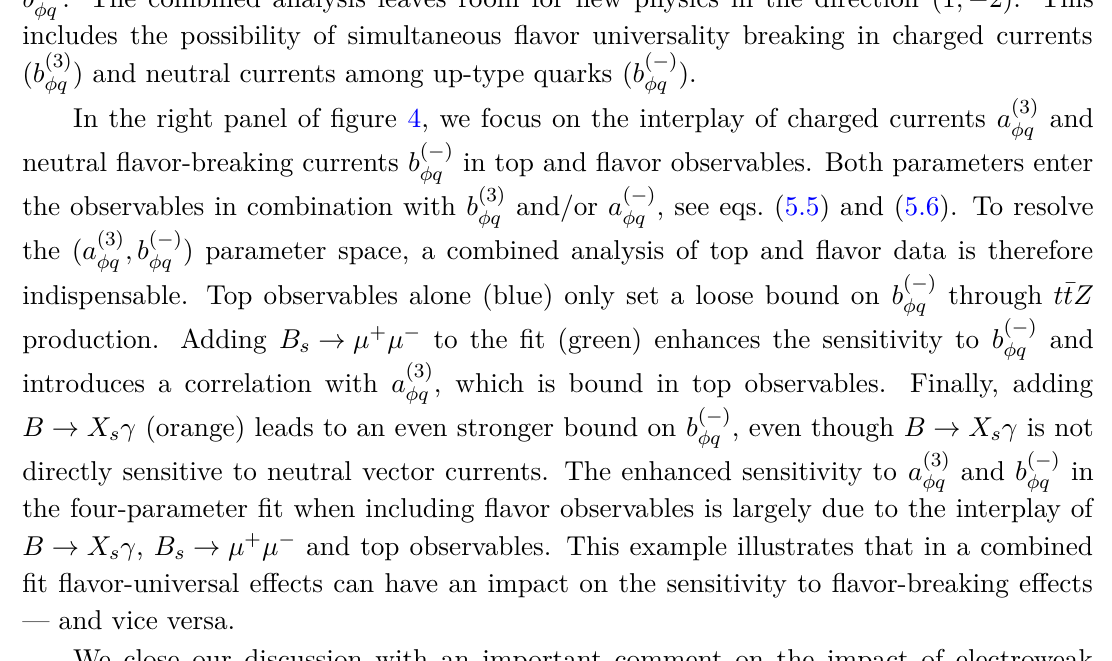
Figure 4 . Flavor structure of two-quark Wilson coefficients C ( − ) in MFV. Shown are the ∆ χ 2 = 2 . 30 (solid) and ∆ χ 2 = 5 . 99 (dashed) contours obtained from